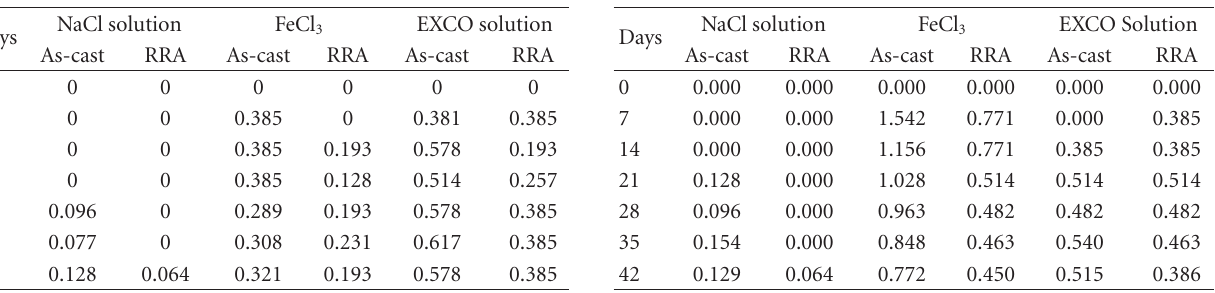
Table 4: Gravimetric corrosion rate (mm/yr) for the 1.23% Mg specimen.